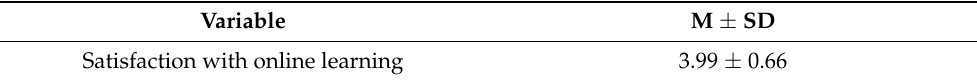
Table 4. Satisfaction with Online Learning ( N